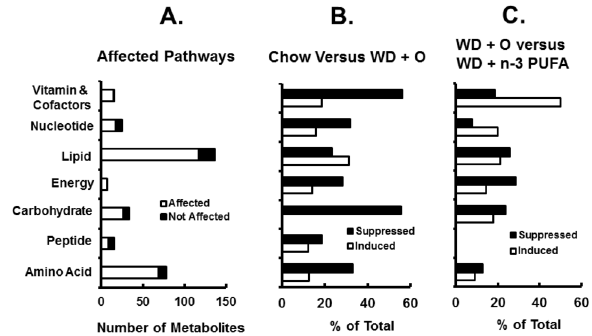
Figure 2. Diet effects on metabolic pathways. Panel A: Number of metabolites significantly changed in each pathway by all diets. Panel B: Percent of metabolites in each pathway that were induced or suppressed in WD + O fed mice relative to chow fed mice. Panel C: Percent of metabolites in each pathway that were induced or suppressed in all WD + C PUFA fed mice relative to WD + O fed mice.